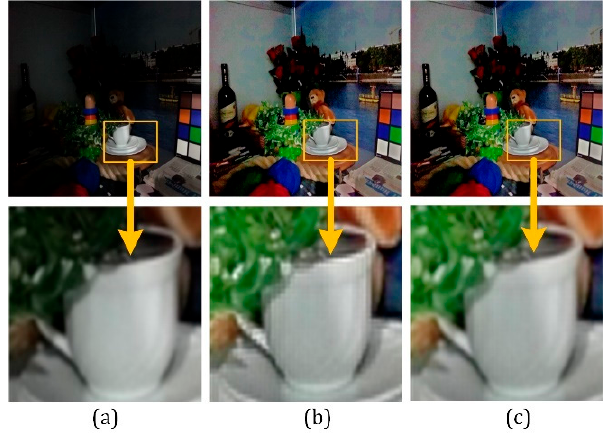
Figure 16. Effect of the smoothness preservation. ( a ) Original image. ( b ) Jagged image after enhancement. ( c )Enhanced image with smoothness preservation.